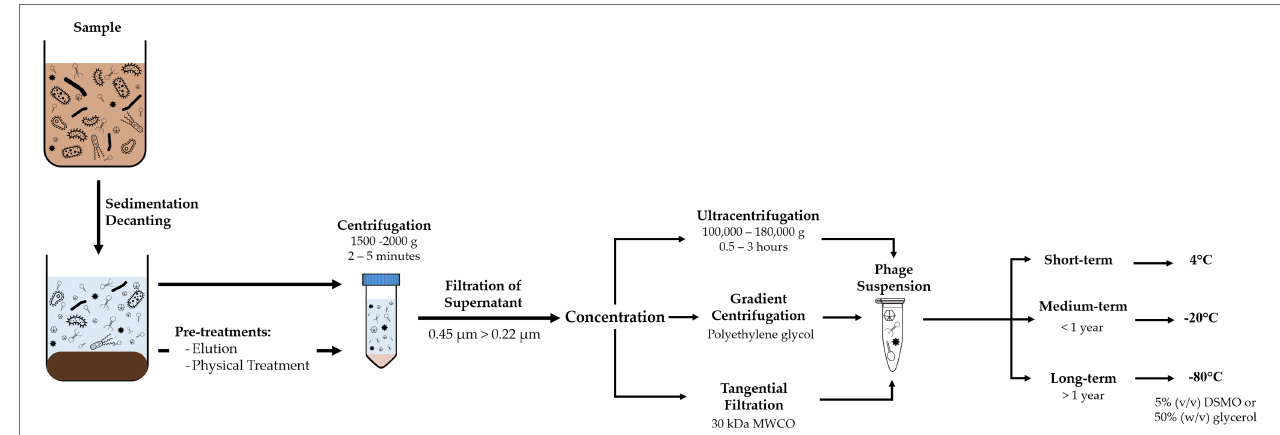
FIGURE 1 | Diagram of methodology for recovery of viruses from environmental samples, comprising removal of suspended solids and concentration of the phage suspension, and adequate storage conditions according to time